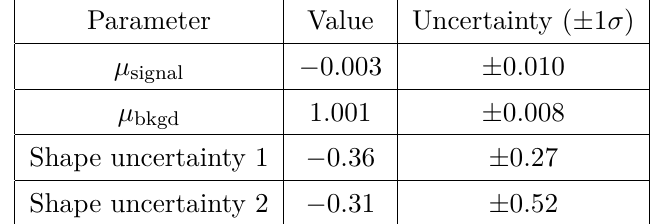
Table 5 . Post-fit parameter values and their associated